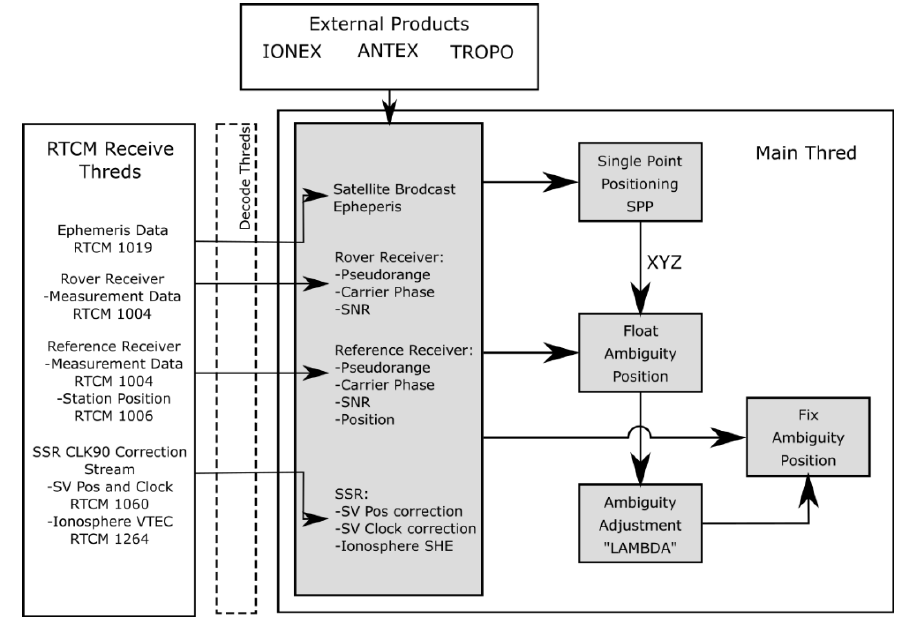
Figure 1. The data flow diagram of the pyGNSS software.